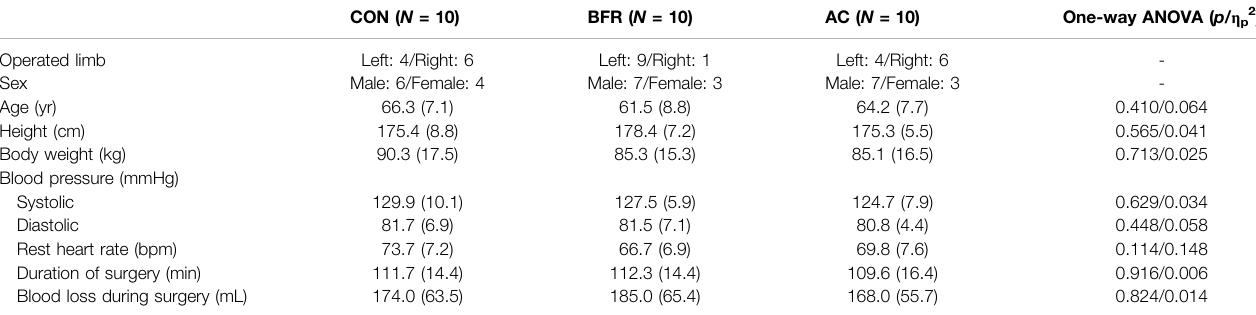
TABLE 1 | Patient characteristics and surgical data for each